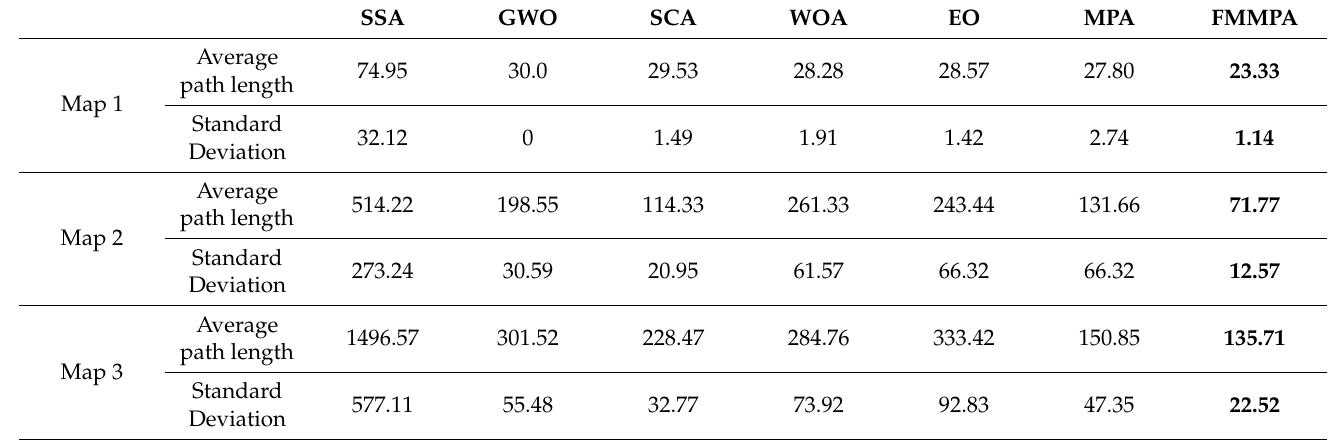
Table 9. Experimental results of 3 different environmental.